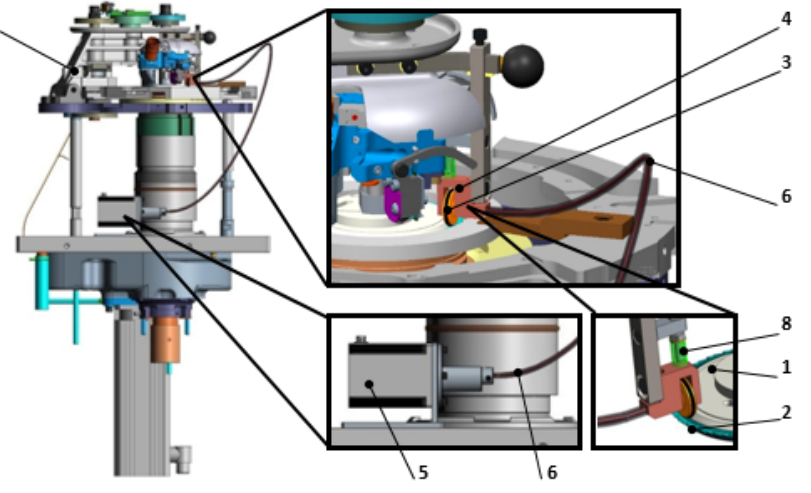
Figure 19. CAD-model of the installation of a functional model of the individual roller cutter drive system into the Ange 18.1 small diameter knitting machine.